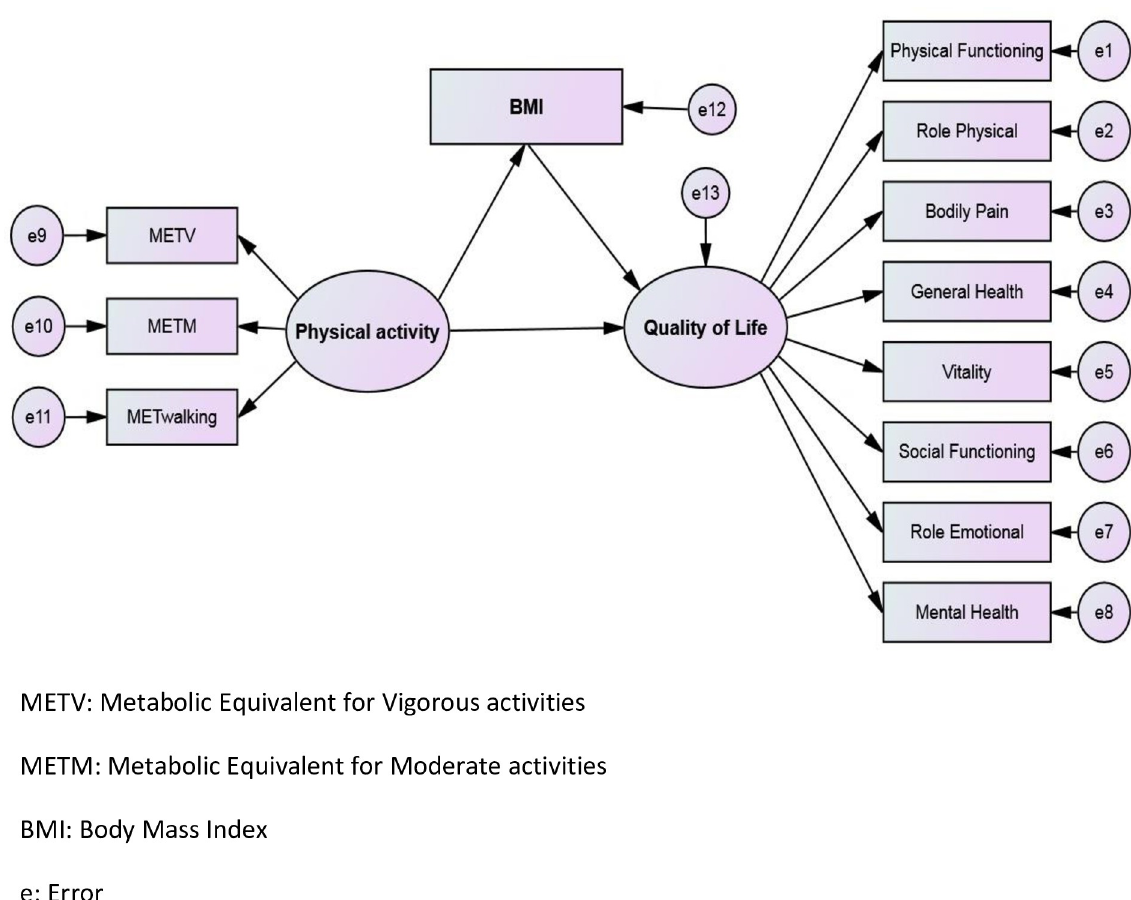
Fig 1. Hypothesized model of the variables (N = 225).